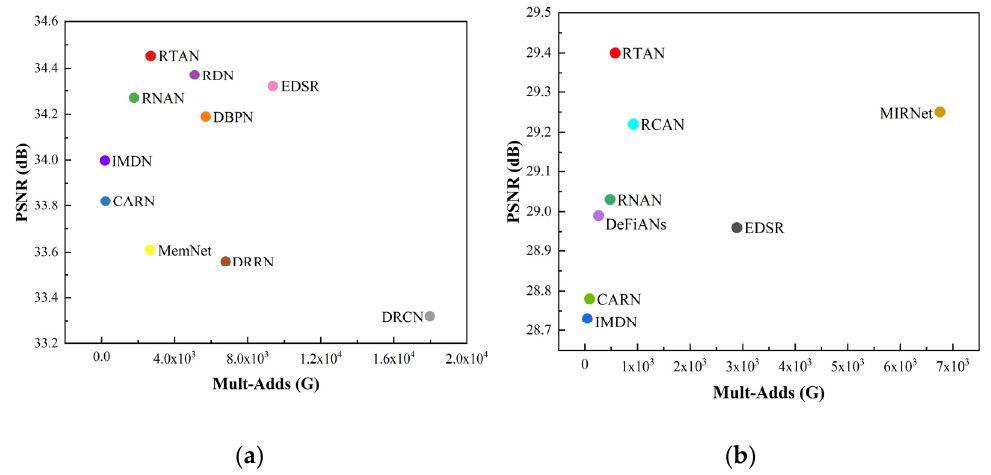
Figure 8. The performance and number of operations. The results are evaluated on four standard benchmark datasets (Set5, Set14, BSD100, Urban100) and two real-world test datasets (Canon, Nikon). ( a ) Results on BI degradation model (2), ( b ) Results on real-world degradation model (×4).